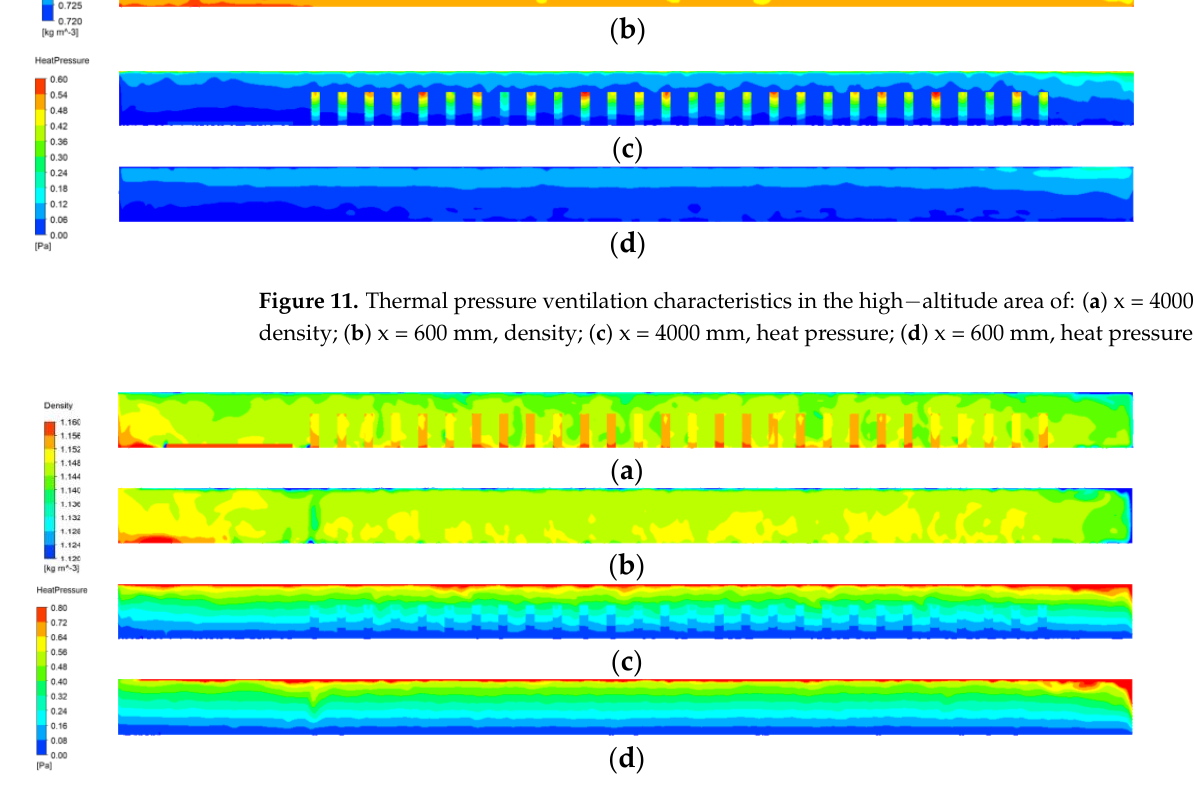
Figure 12. Thermal pressure ventilation characteristics in the plain area of: ( a ) x = 4000 mm, density; ( b ) x = 600 mm, density; ( c ) x = 4000 mm, heat pressure; ( d ) x = 600 mm, heat pressure.